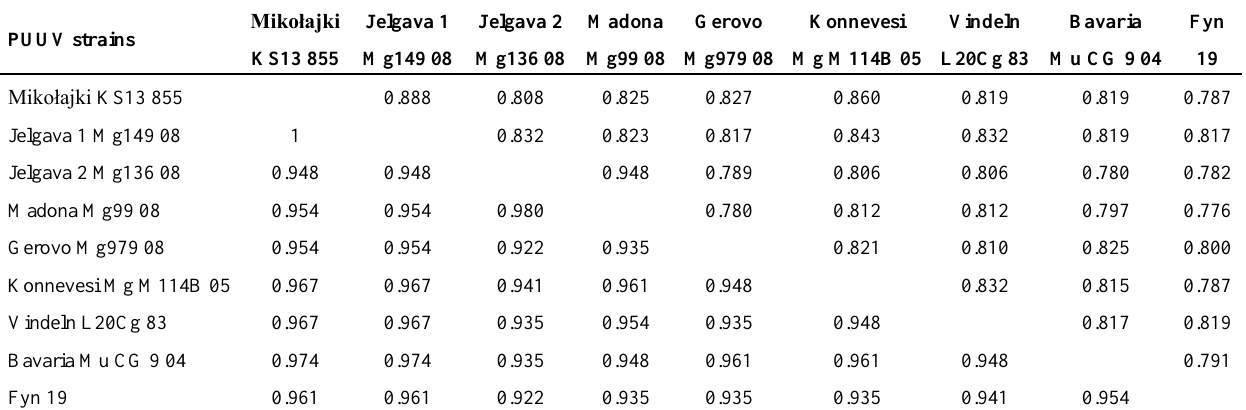
Table 2. Nucleotide (above the diagonal) and amino acid sequence identity of the novel S segment and nucleocapsid protein sequence from Mikołajki with corresponding sequences from Latvia, Croatia, Finland, Sweden, Germany and Denmark. PUUV strains KS13